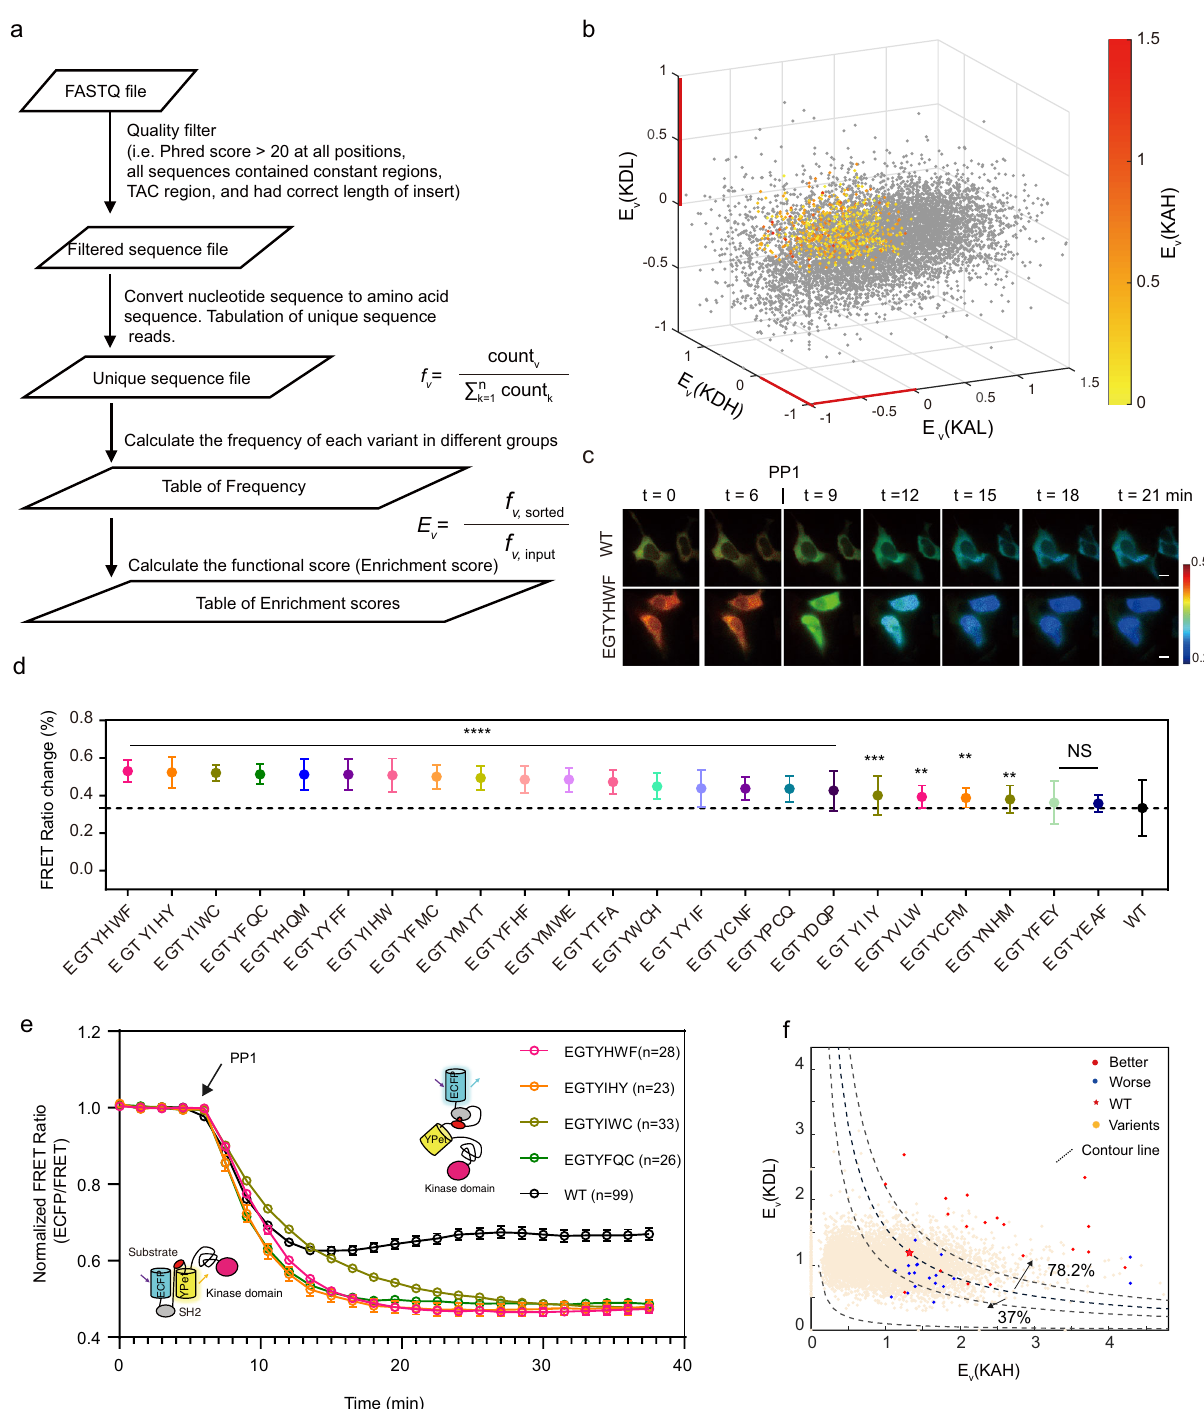
Quality filter (i.e. Phred score > 20 at all positions, all sequences contained constant regions, TAC region, and had correct length of insert)